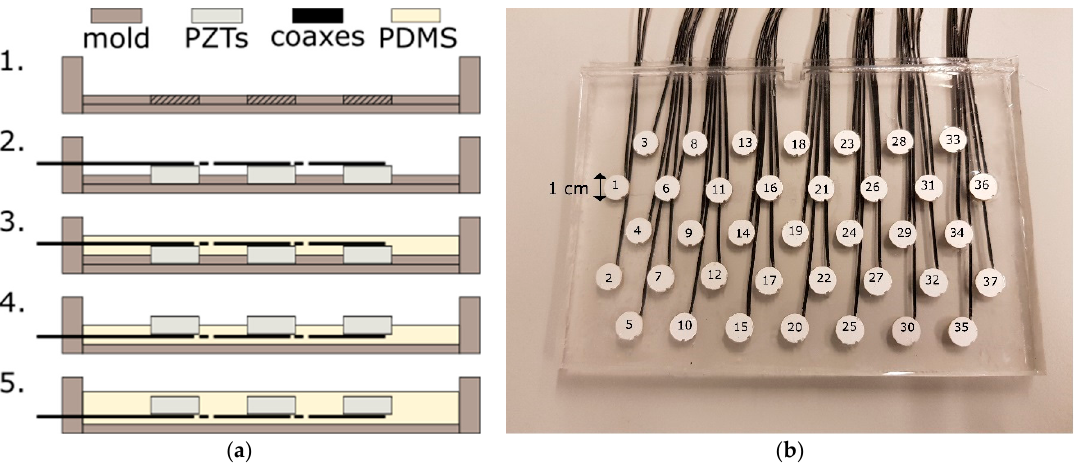
Figure 1. ( a ) Process of making a flexible transducer array. (1) Polymethylmethacrylat (PMMA) mold with plate for inserting (2) the piezotransducers. (3) Casting Polydimethylsiloxan (PDMS) on the backside of the transducers. (4) Flipping the first cast to mold a second layer of PDMS on the front side of the transducers (5) to create an air-free layer above the transducer elements. The processing steps are described in detail in Section 2.1; ( b ) Photograph of the flexible transducer array. For reference, the element number is shown on top of each transducer element.